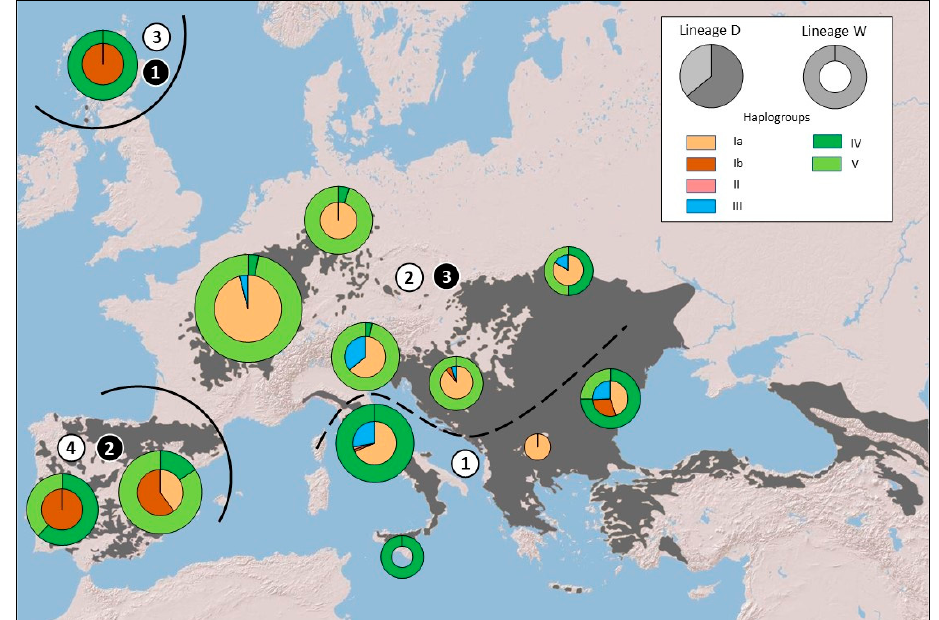
Figure 3. Distribution map of the main six haplogroup clades derived from the Bayesian tree. Donut charts show the proportional frequency of haplogroups of lineage W. The inscribed pie charts show the proportional frequency of lineage DW (lineage D pruned by domestic cats). Circles are approximately proportional to sample size. Black solid curved lines trace the geographical separations among genetic clusters detected in both lineages W and DW through SAMOVA analyses, while dotted line shows the additional genetic separation found for lineage W. Black numbers in white circles indicate the clusters found by SAMOVA analyses for lineage W. White numbers in black circles show the clusters found by SAMOVA analyses for lineage DW.